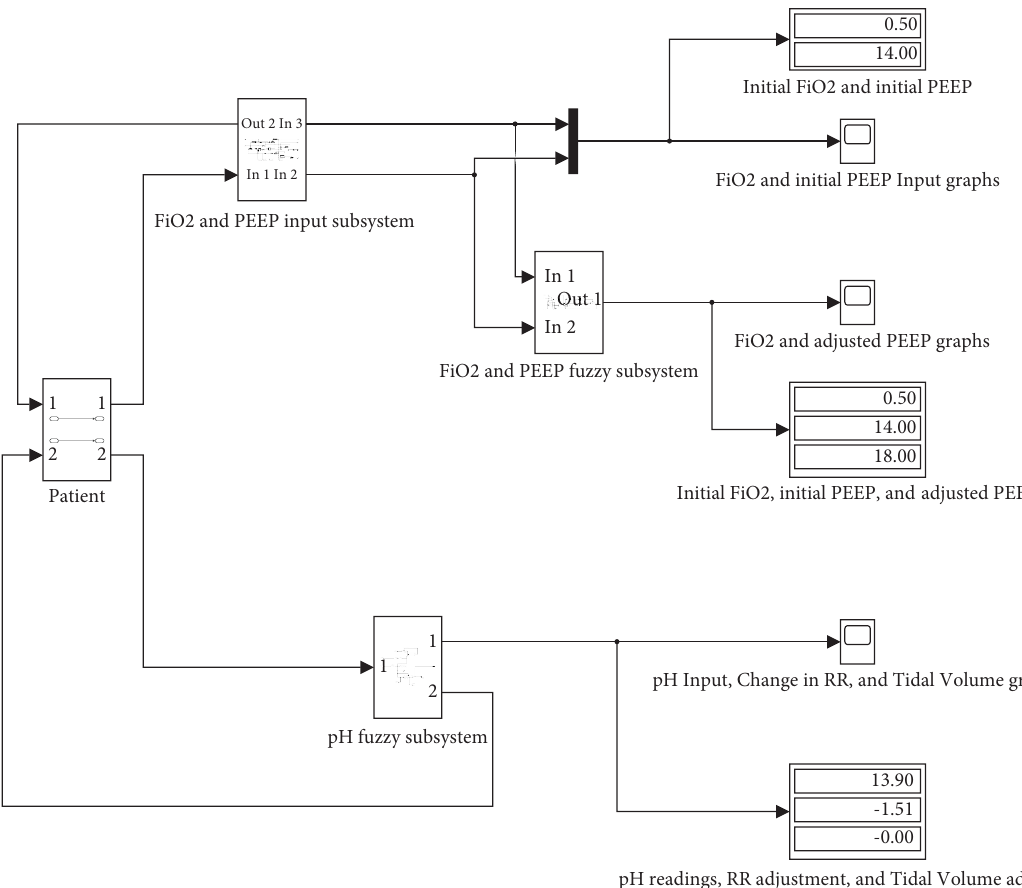
Figure 1: General fuzzy based ARDS Berlin defnition.